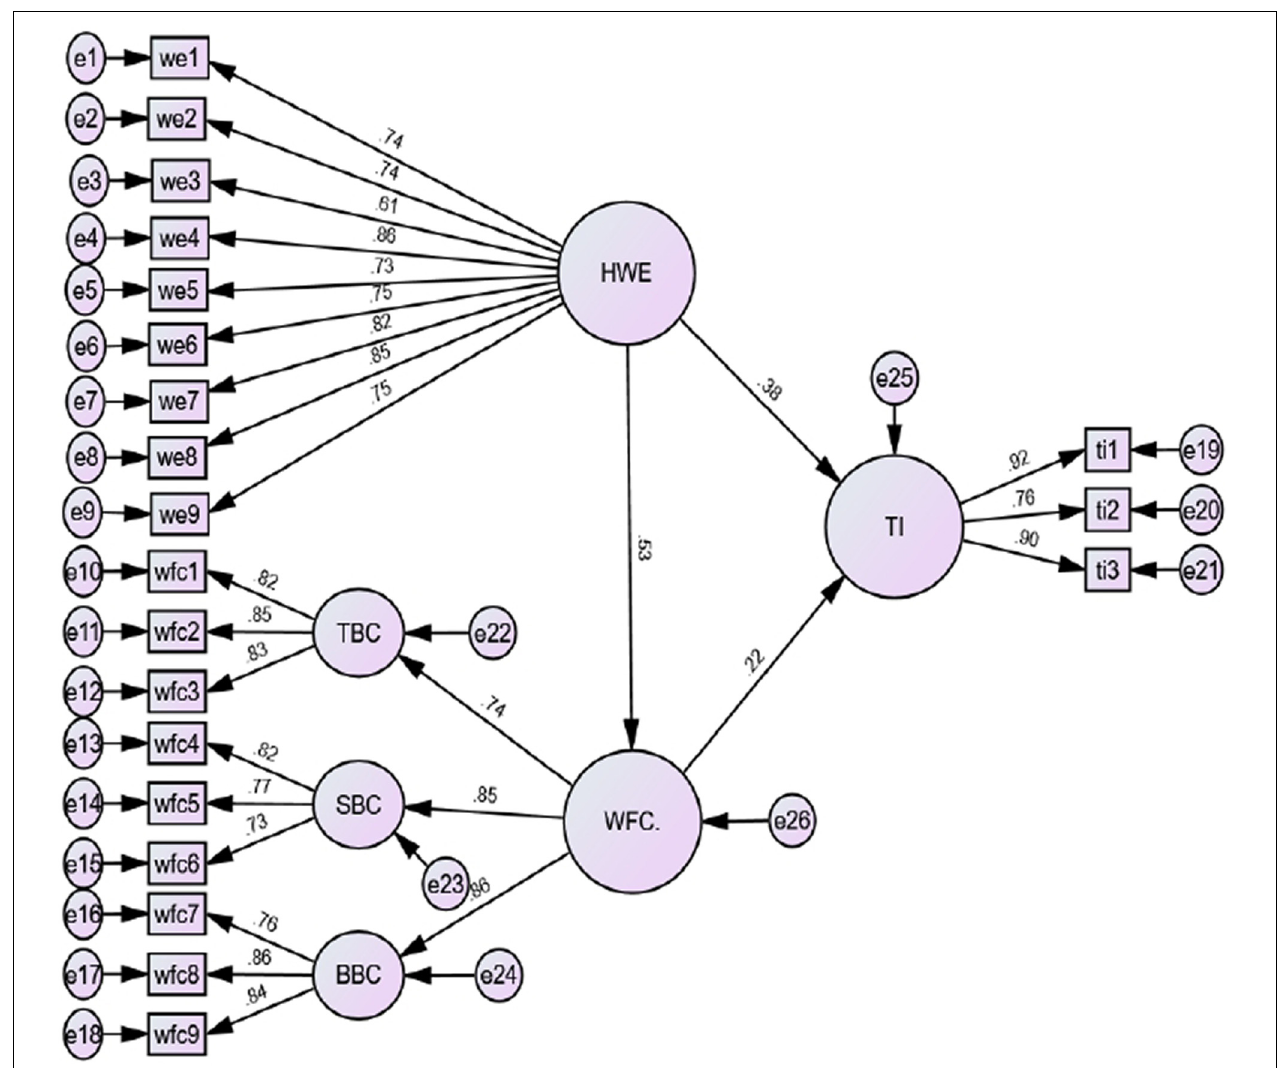
FIGURE 3 | The structural